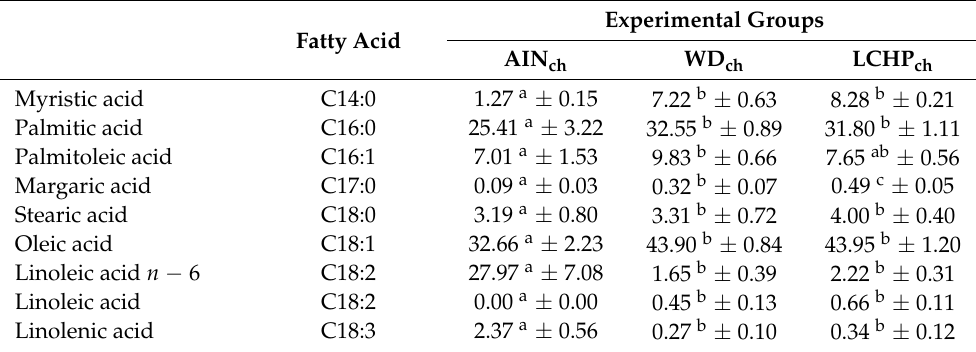
Table 5. Fatty acid profile (%) in adipose tissue of rats after 8 weeks of feeding: AIN ch , WD ch (Western diet) or LCHP ch (low-carbohydrate–high-protein) diets enriched with 1% cholesterol.